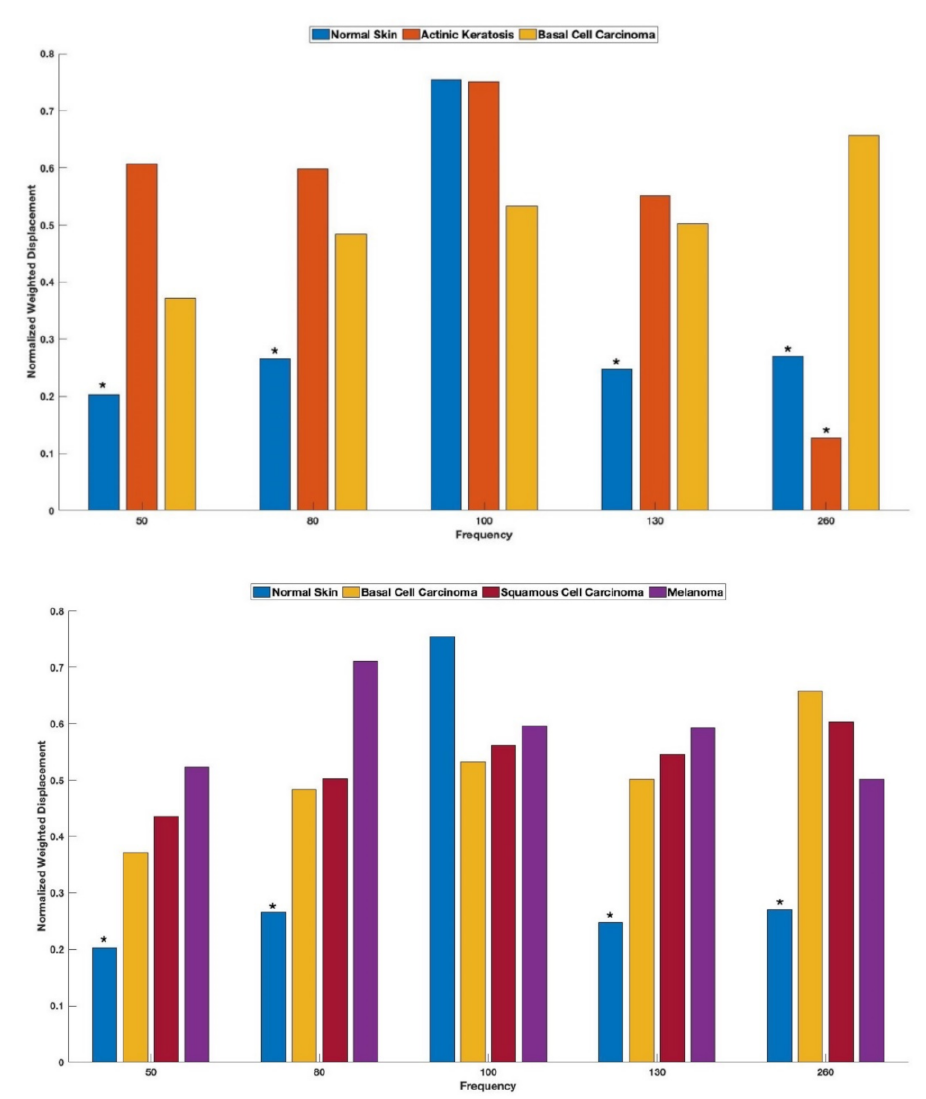
Figure 8. Normalized peak heights obtained from weighted displacement versus frequency plots for skin lesion cross-sections shown in Figure 2B through Figure 7B for 50 Hz, 80 Hz, 100 Hz, 130 Hz, and 260 Hz resonant frequency peaks. The peak heights were normalized by dividing by the largest peak observed in each spectrum for normal skin, AK, BCC, SCC, and melanoma. Note that the nodular and superficial BCC data have been combined in this figure. The top figure illustrates that the normalized peak heights at 50, 80, 130, and 260 Hz for normal skin, AK, and BCC are significantly different at a 0.95 confidence level (*) using a two-tailed Student’s t-test. However, the peak heights were not significantly different than for BCC, SCC and melanoma. The lower figure illustrates that the normalized peak heights were significantly different at a 0.95 confidence level (*) for normal skin at 50, 80, 130, and 260 Hz compared to BCC, SCC and melanoma. The data in this figure illustrate that normal skin has different normalized peak heights from all lesions studied. However, the peak heights, resonant frequencies, and moduli alone are insufficient to determine differences among BCC, SCC, and melanoma. The ratios of normalized peak heights can be used to differentiate among normal skin and different skin cancers, as can be seen in Table